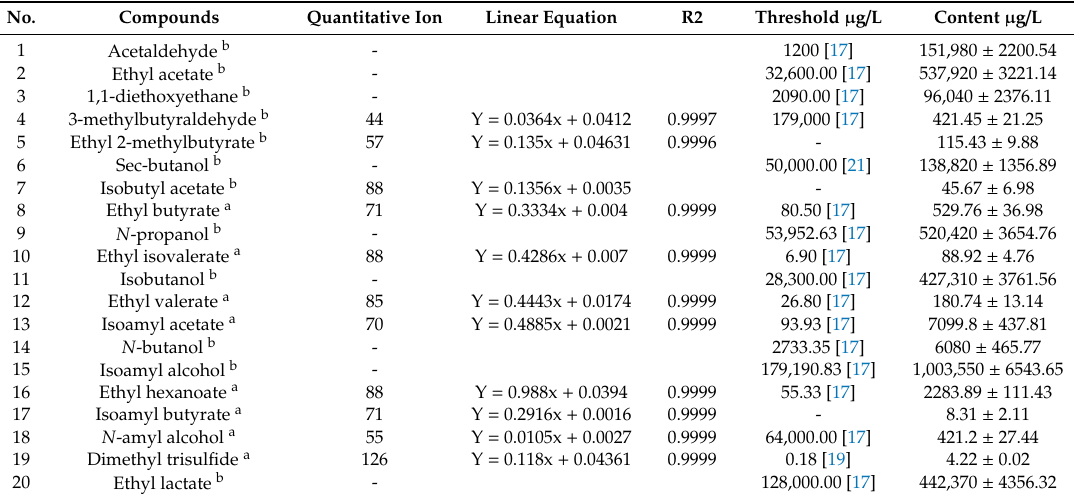
Table 3. Quantitative results of volatile compounds in